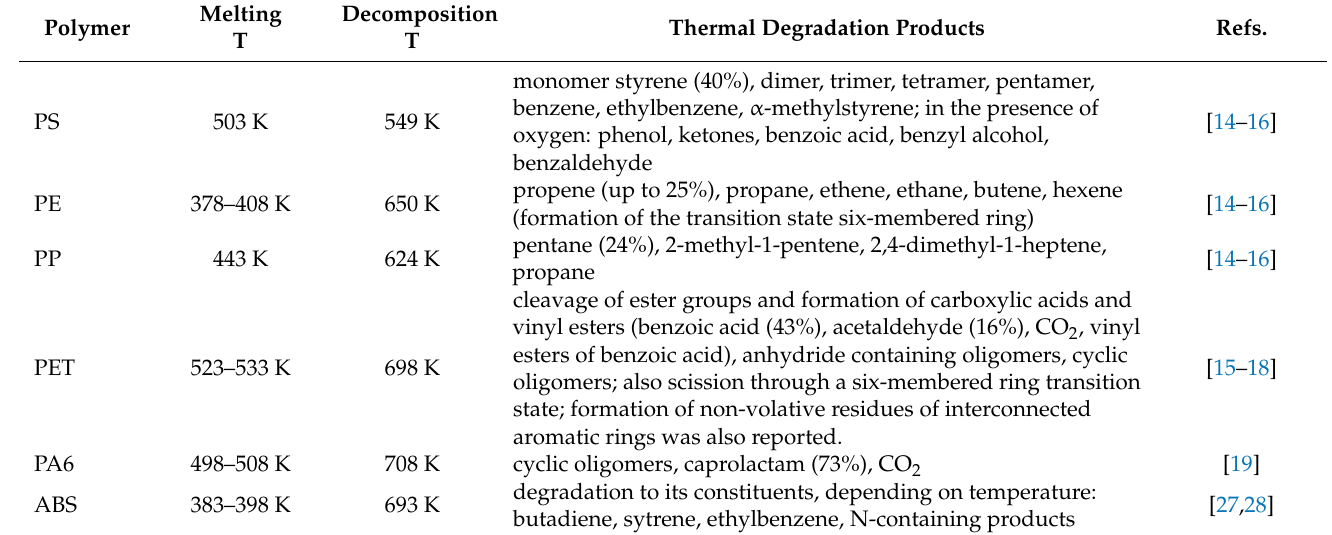
Table 2. Thermal and photooxidative degradation products. Information for melting and deposition temperature was obtained from